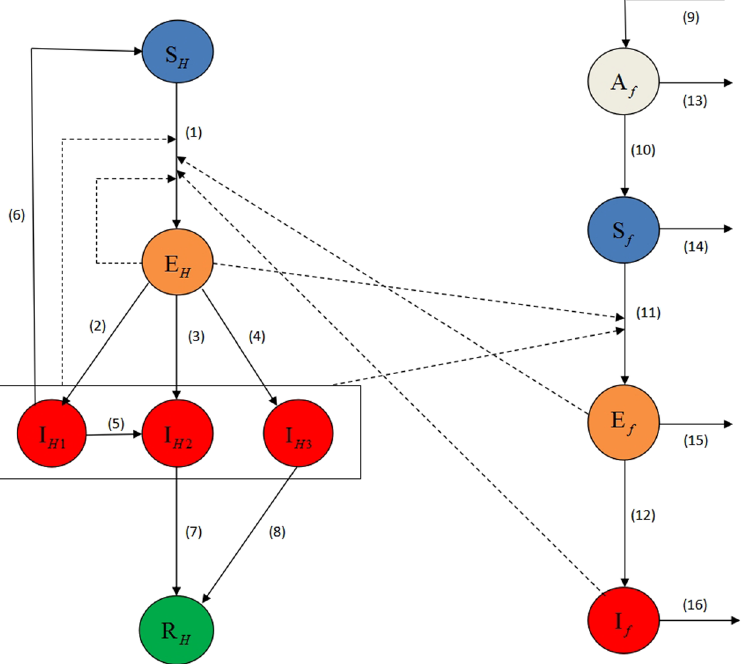
Figure 2. Dynamical transmission flow diagram of Zika among humans and mosquitoes. Subscripts H and f indicate humans and Wolbachia-free mosquitoes, and A , S , E , I , and R indicate aquatic, susceptible, exposed, infectious and recovered populations, respectively. The parameters are given in Table